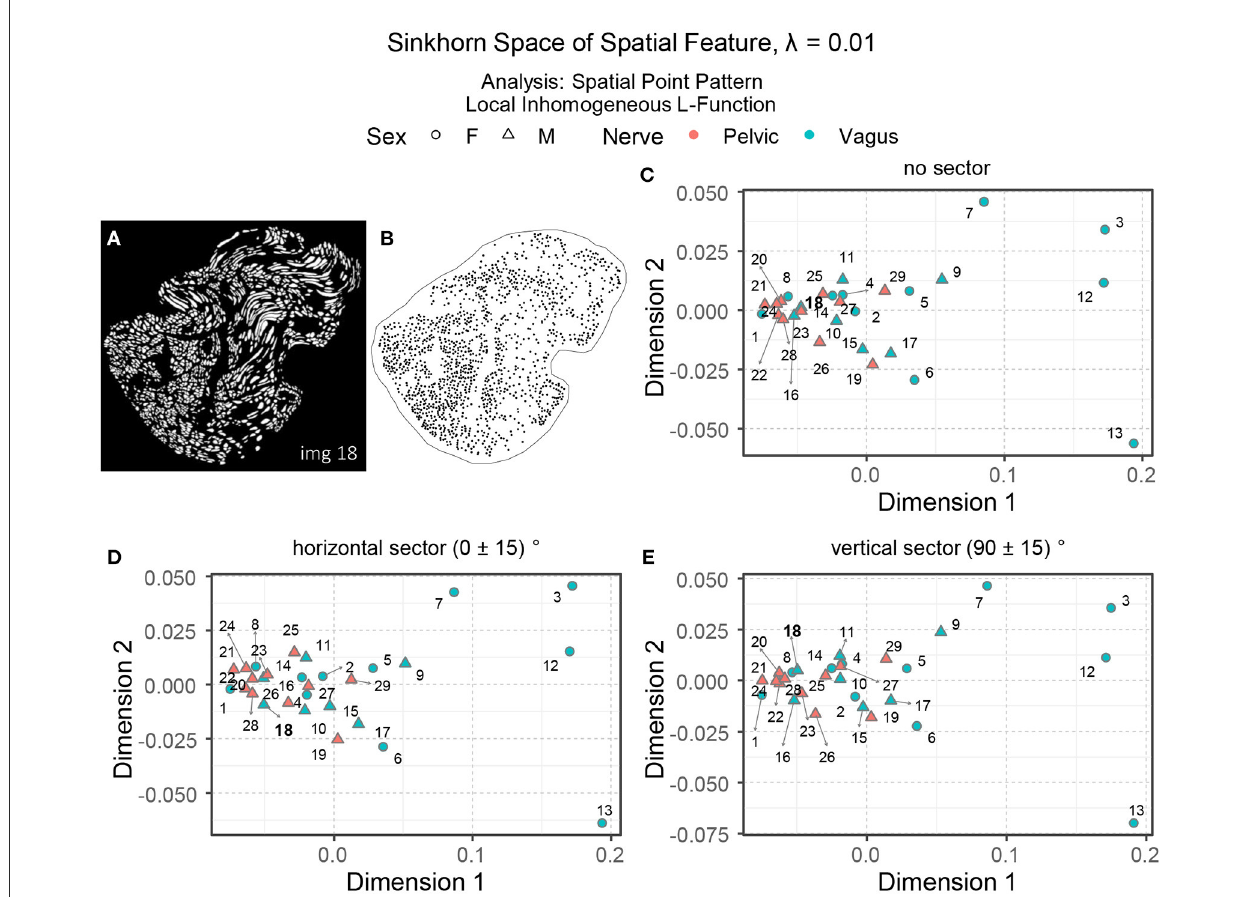
FIGURE10 (A, B) The segmented unmyelinated axons and the spatial point pattern of Image 18 (vagus) listed in Table 1. (C–E) The embeddings of the local inhomogeneous and anisotropic L -functions (no sector, horizontal sector, and vertical sector) of the spatial point patterns in the Sinkhorn space for entropic regularization parameter λ = 0.01. The vagus and the pelvic samples are shown in cyan and orange [circles for female (F) and triangles for male (M)], respectively, and labeled with the Image ID listed in Table